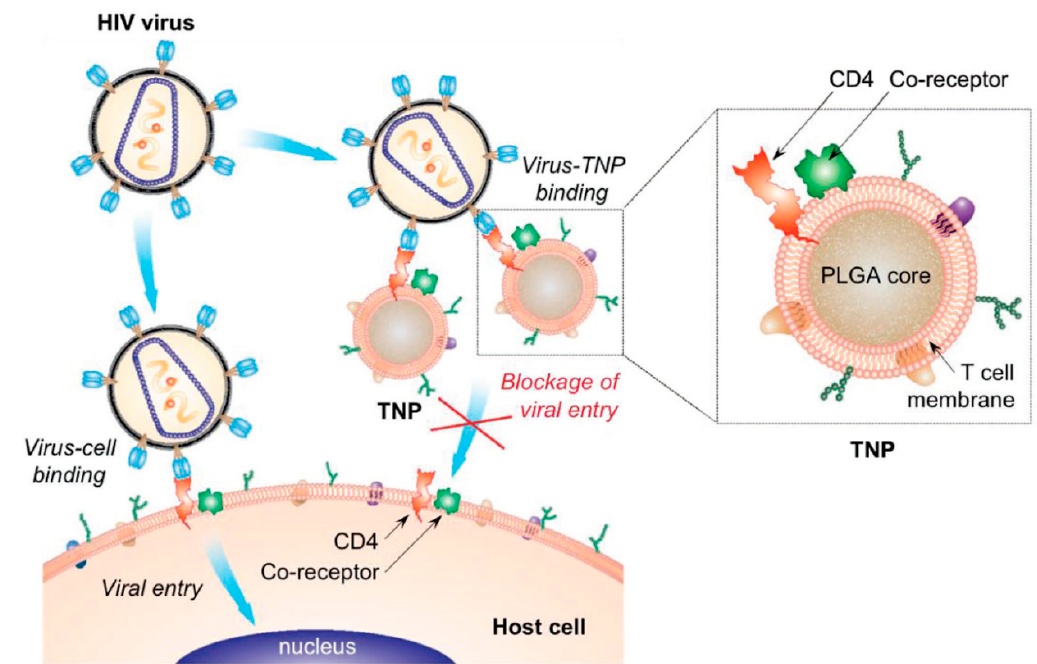
Figure 6. Schematic of T-cell membrane coated nanoparticle (NP)-mediated depletion of HIV infection. Reproduced with permission from from Ref. [47], Copyright © WILEY-VCH Verlag GmbH & Co. KGaA, Weinheim.